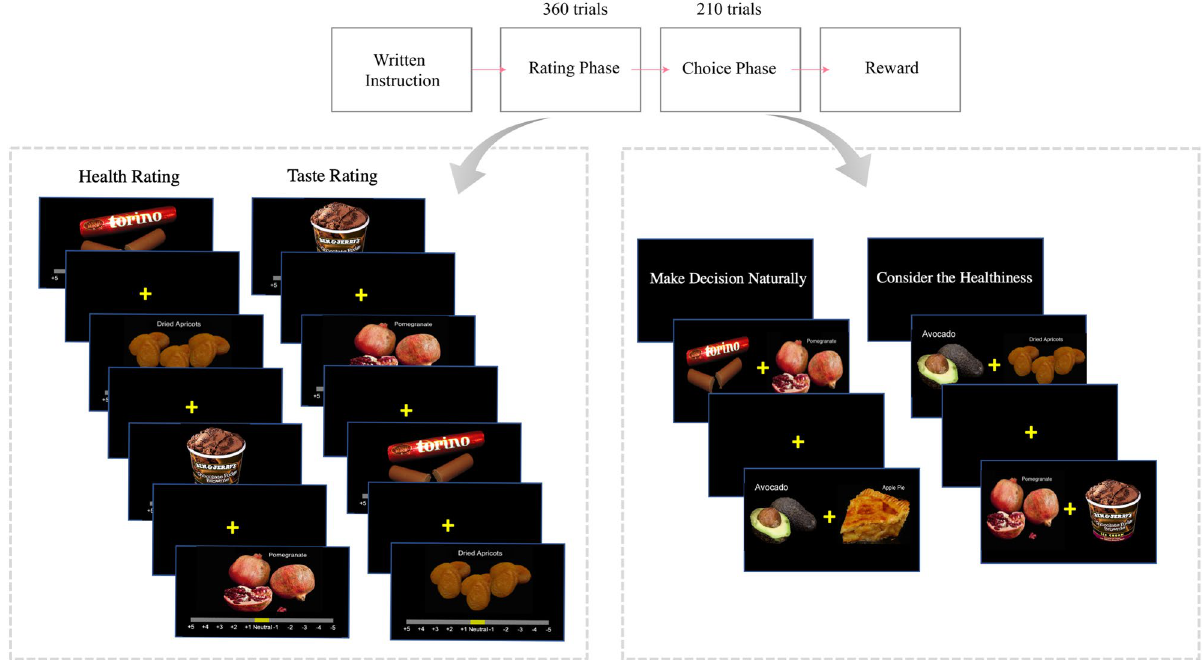
Figure 1. Experiment structure. The experiment had two phases, ratings and choices. In the ratings phase, participants rated the taste and health aspects of the foods using a visual analog scale ranging from − 5 to + 5. The order of the two ratings was counterbalanced. In the choice task, participants had to choose one of the two food items to eat at the end of the experiment. Within the choice phase, there were two conditions that differed in the attention cues given to the participants. In the health-cued condition, subjects were cued to consider the healthiness of the foods while making decisions. In the natural-cued condition, subjects were cued to make decisions naturally using whatever features freely came to mind. At the end of the session on each day, one of the participant’s choices was randomly selected and the participant was given the chosen food to eat in the behavioral